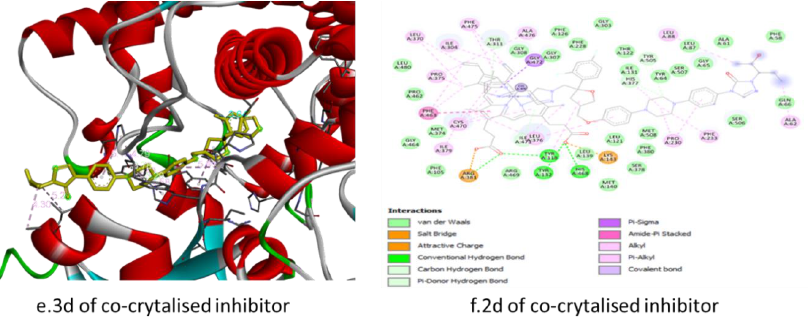
Figure 14. Interaction of the docked compounds 6 and 7, and the co-crystalized substrate with fungal sterol 14 α -demethylase (CYP51). In the light of in vitro and silico results, one could recommend compounds 2 , 6 , and 7 for further steps of drug development as antimicrobial agents.